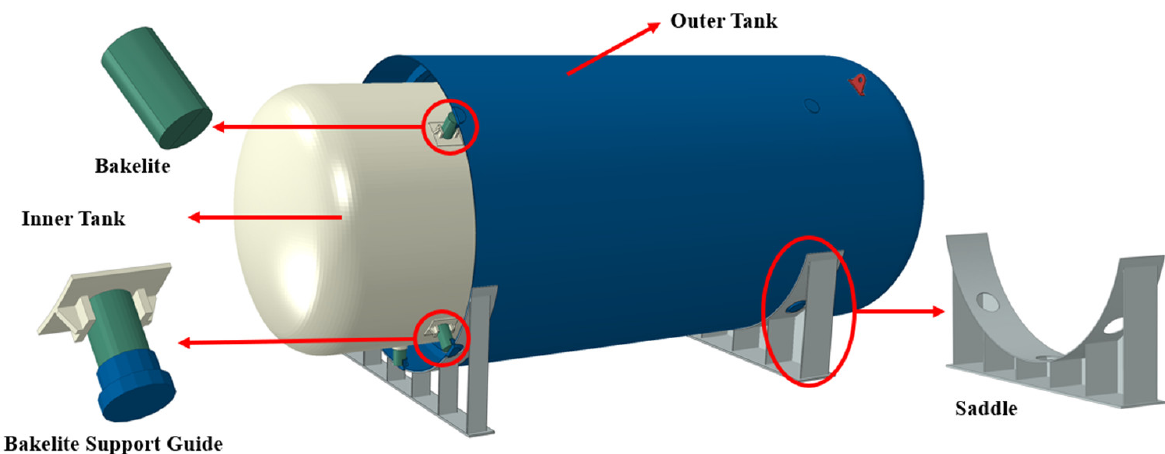
Figure 3. Geometry of LNG fuel tank.